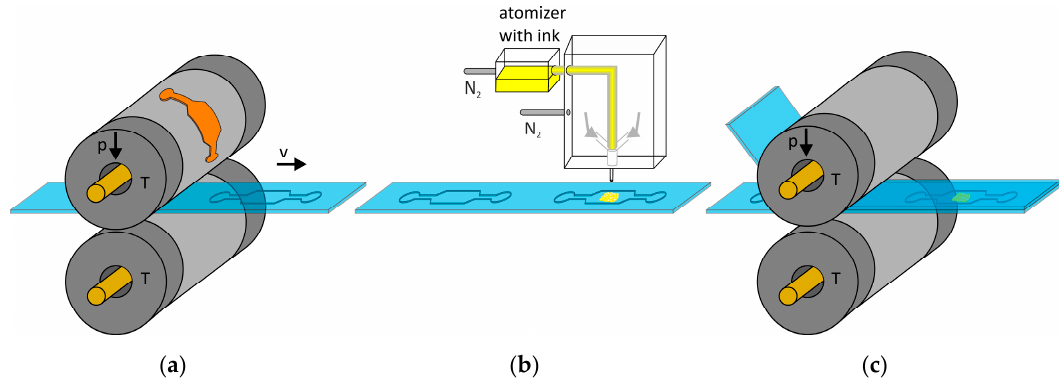
Figure 1. Fabrication process of optofluidic chips for surface-enhanced Raman spectroscopy (SERS). roll-to-roll (R2R) hot embossing of polystyrene (PS) foil ( a ), followed by modification with aerosol jet printed Au nanoparticles ( b ) and sealing of the chip with a PS cover foil by R2R bonding ( c ).